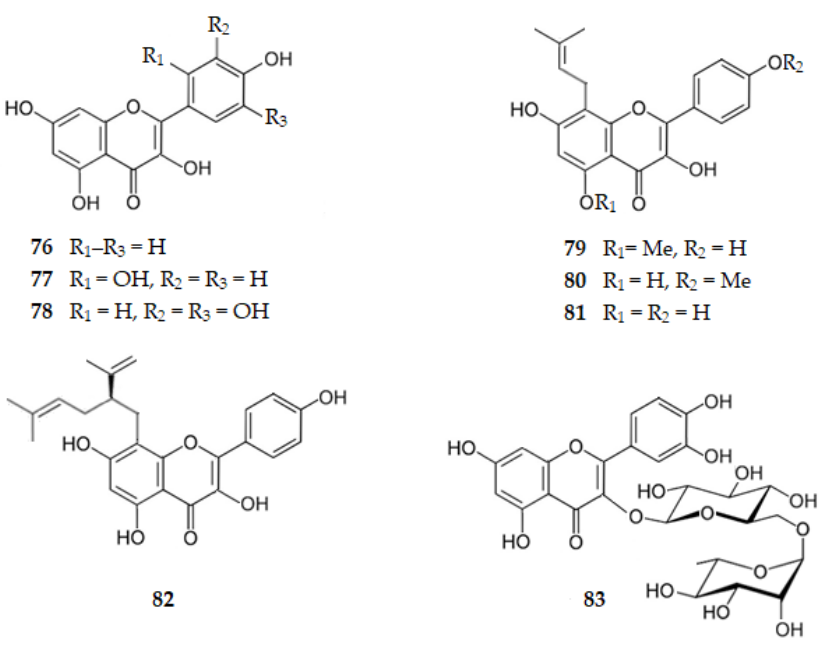
Figure 8. Structure of flavonols that inhibit β